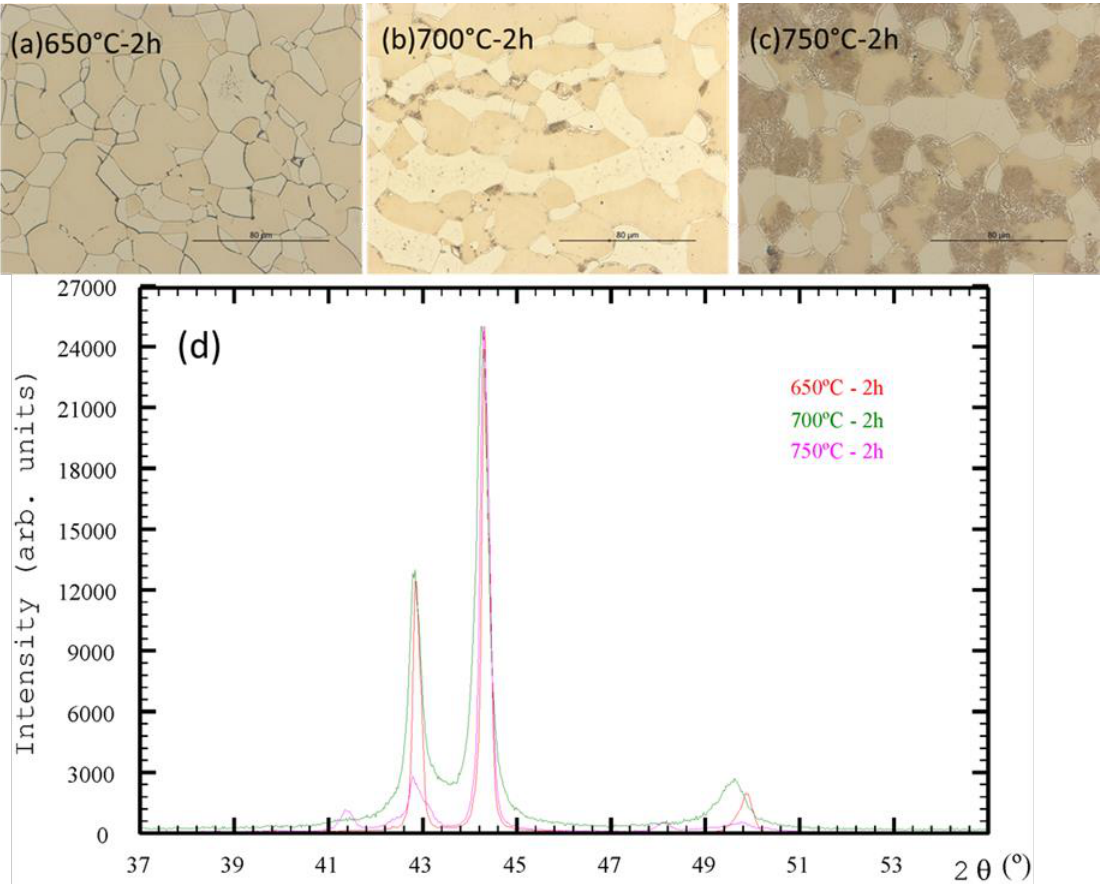
Figure 7. Optical microscope micrographs of the alloy after heat treatments performed for 2 h at ( a ) 650 °C, ( b ) 700 °C and ( c ) 750 °C. In ( d ), their corresponding diffractograms are shown.